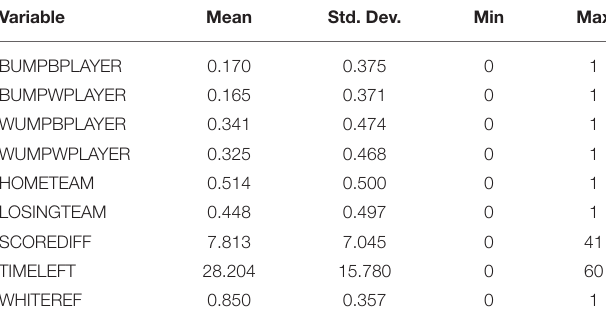
TABLE 1 | Player-level summary statistics ( N = 1,628).